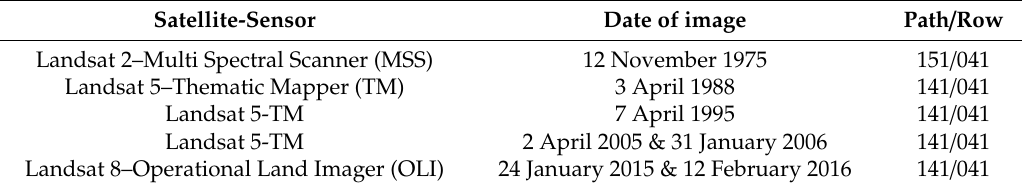
Table 1. Landsat images used for mapping the land use / land cover (LULC) of the catchment.